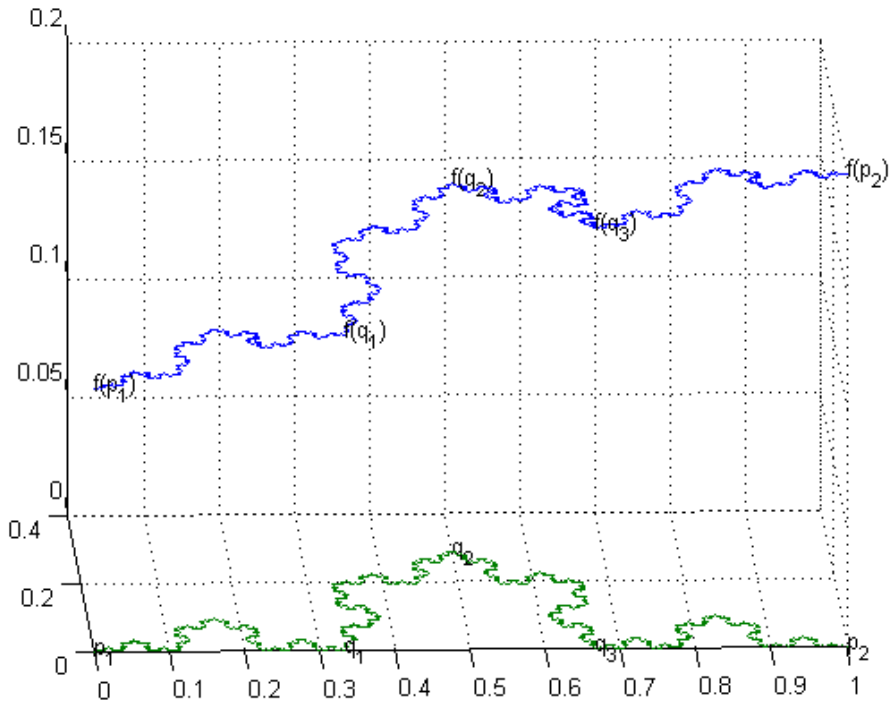
Figure 6. A fractal interpolation function on the Koch curve